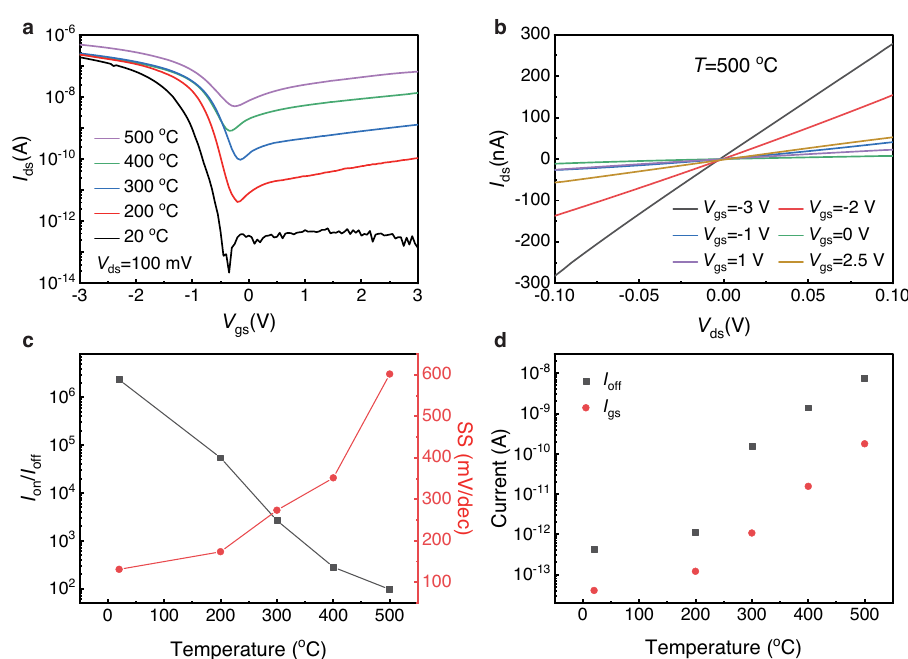
Fig. 3 | Electrical characteristics of WSe 2 FET measured under high tempera- ture. a Transfer curves of WSe 2 FET measured under different temperatures. I ds is the drain current and V ds is voltage between drain and source. b I ds - V ds curves of WSe 2 FET measured under 500°C. V gs is voltage between gate and source. c I on / I off